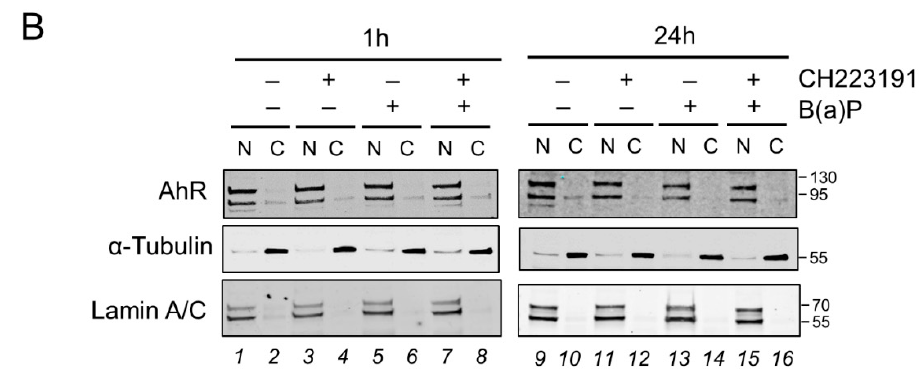
Figure 6. AhR localization in BeWo after incubation with benzo-(a)-pyrene. BeWo cells (at 70% confluence) were either used as control (solvent DMSO) or incubated with 1 µM B(a)P for the indicated times, in the presence or absence of a pre-incubation (1h before B(a)P) with 3 µM CH223191, an inhibitor of AhR, as indicated. ( A ) BeWo cells were fixed in 4% PFA and permeabilized with methanol. Images are of epifluorescence microscopy (400× magnification) after staining AhR with WH0000196-M2 antibody (green) and nuclei (DAPI). Overlays are in the right panel. ( B ) Cells were fractionated into nuclear (N) and cytosolic (C) fractions and subjected to Western blot. Immunoblotting was carried out using AhR (WH0000196-M2) antibody, and fractions purity was assessed with α -Tubulin (cytosolic) and Lamin A/C (nuclear).